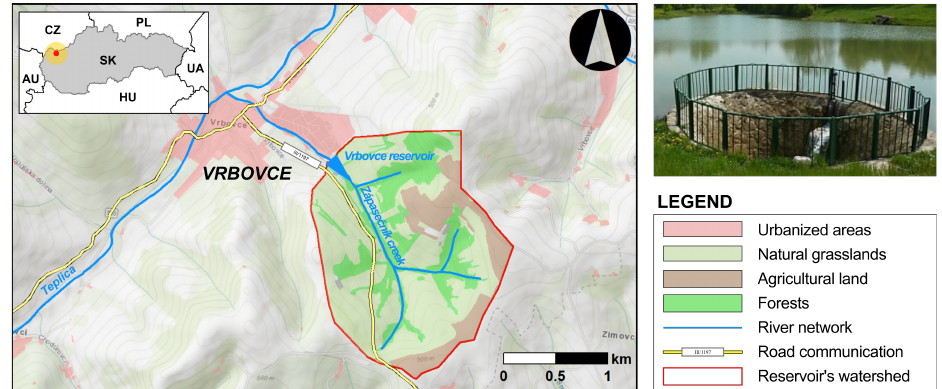
Figure 1. Location of the area of interest within Slovakia. The upper right-hand picture shows the emergency spillway with an embedded sluice gate acting as an additional outlet structure. The embankment dam of the reservoir has a height of 5.9 m, with a 3 m wide crest at an altitude of 350.0 m a.s.l. Its upstream slope has a ratio of 1:3 and is reinforced with a rip-rap, while the downstream slope has a ratio of 1:2 and is covered with grass. The bottom outlet from the reservoir is a concrete pipe of 150 mm in diameter, with its bottom edge lying on the reservoir’s bed at an altitude of 344.1 m a.s.l. According to the current operational manual of the reservoir, this outlet is always kept closed. The water level in the reservoir can be partially controlled by a small vertical sluice gate (0.8 m × 1.0 m) embedded in the emergency spillway (see Figure 2). The emergency spillway was designed as an uncontrolled bell-mouth spillway, with its edge at an altitude of 348.25 m a.s.l. and an outer diameter of 6 m. The relationship between the elevation of the water level and